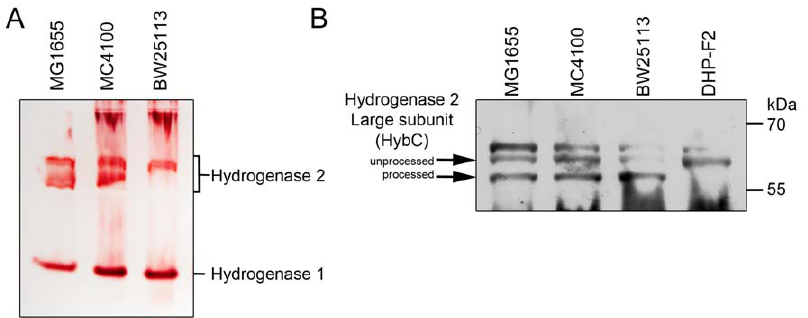
Figure 3. Comparative analysis of hydrogen-uptake hydrogenases in different E.coli K-12 derivatives. A. Aliquots of crude extracts (25 m g protein) derived from the bacterial strains shown were separated by non-denaturing PAGE (7.5% w/v polyacrylamide) and subsequently stained for hydrogenase enzyme activity. The locations of hydrogenase 1 and hydrogenase 2 activity bands are shown. B. Western blot analysis of the unprocessed and processed forms of the HybC large subunit of hydrogenase 2 was performed using crude extracts (25 m g protein) derived from the bacterial strains indicated. Strain DHP-F2 is a derivative of MC4100 carrying a deletion in the hypF gene.